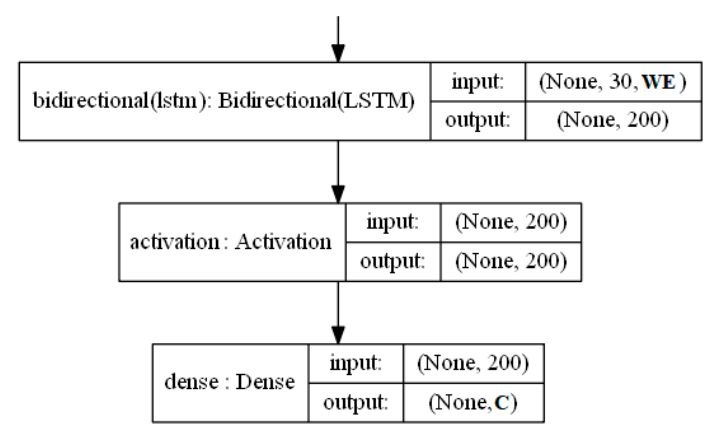
Figure 5. The optimal LSTM model architecture on chatbot for the Latvian language. Appl. Sci. 2020 , 10 , x FOR PEER REVIEW